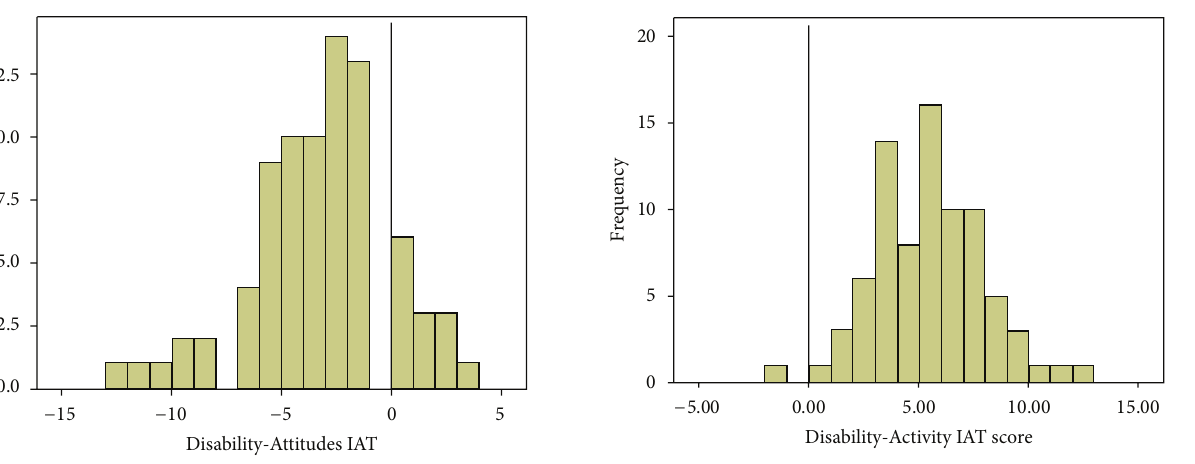
Figure 2: Frequency of Disability-Attitudes IAT scores. Vertical line represents a score of zero, the score associated with no bias towards people with a physical disability. Negative scores represent negative attitudes towards people with a physical disability and positive scores represent positive attitudes towards people with a physical disability.